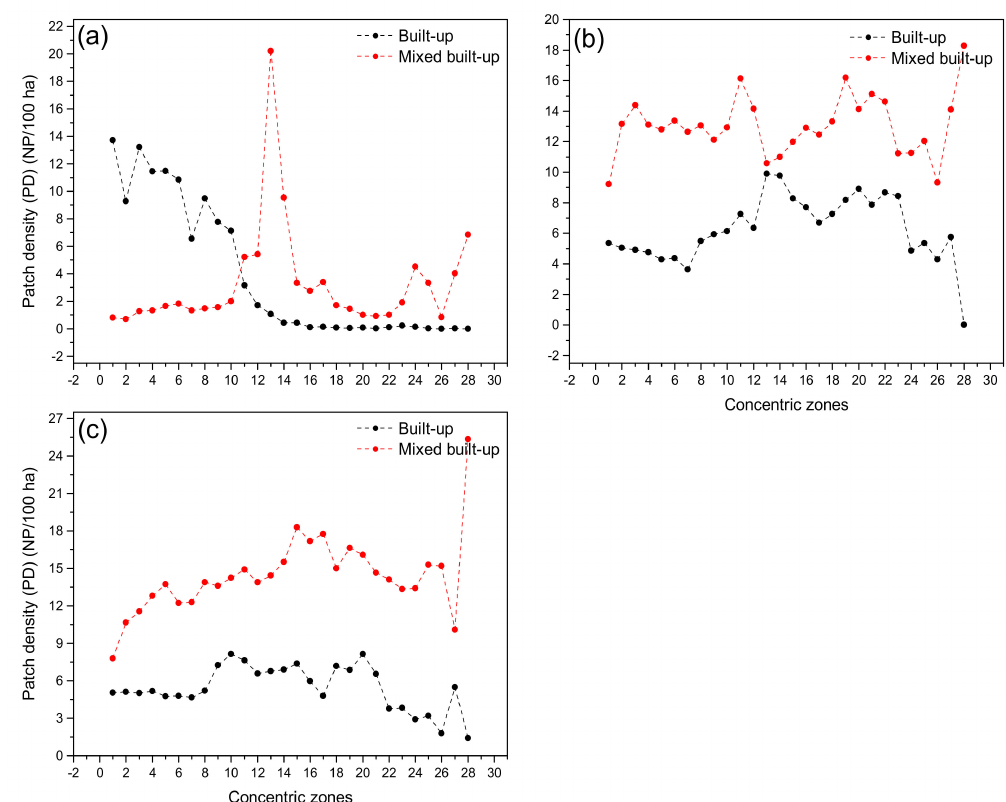
Figure 17. Pattern of PD plotted against the sequential concentric zones of 1 km each around the river Hooghly within the KMA; the pattern of PD of built-up and mixed built-up for the concentric zones in ( a ) 1996, ( b ) 2006, and ( c ) 2016.